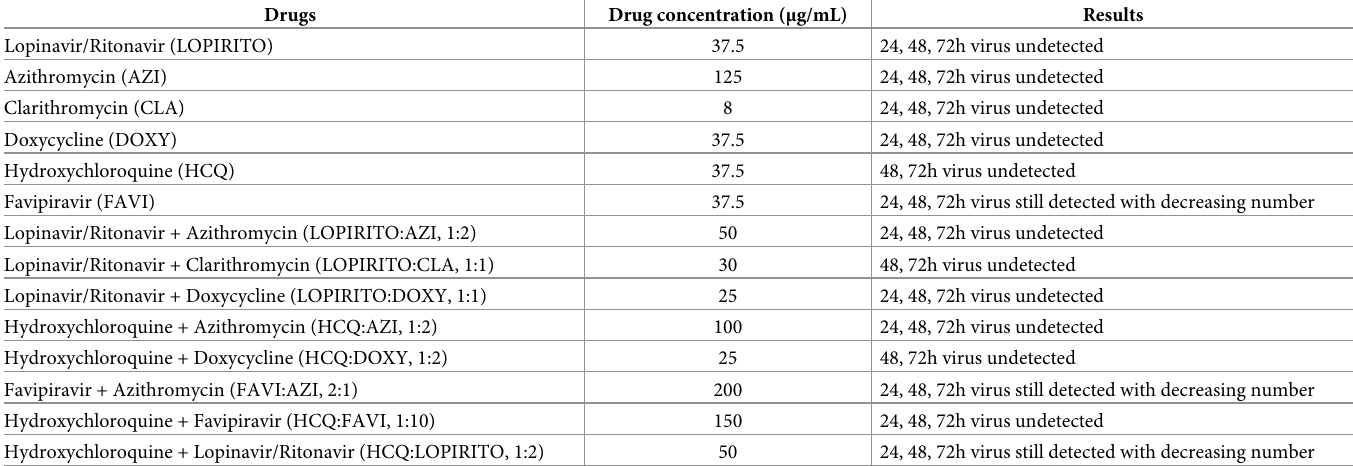
Table 4. The concentration of single and combination drugs (at a mass ratio) that produced an undetected virus copy number in the in vitro antiviral study against Vero cells infected with SARS-CoV-2 at a multiplicity of infection (MoI) value of 0.04 at 24, 48, and/or 72 hours’ incubation. Drugs